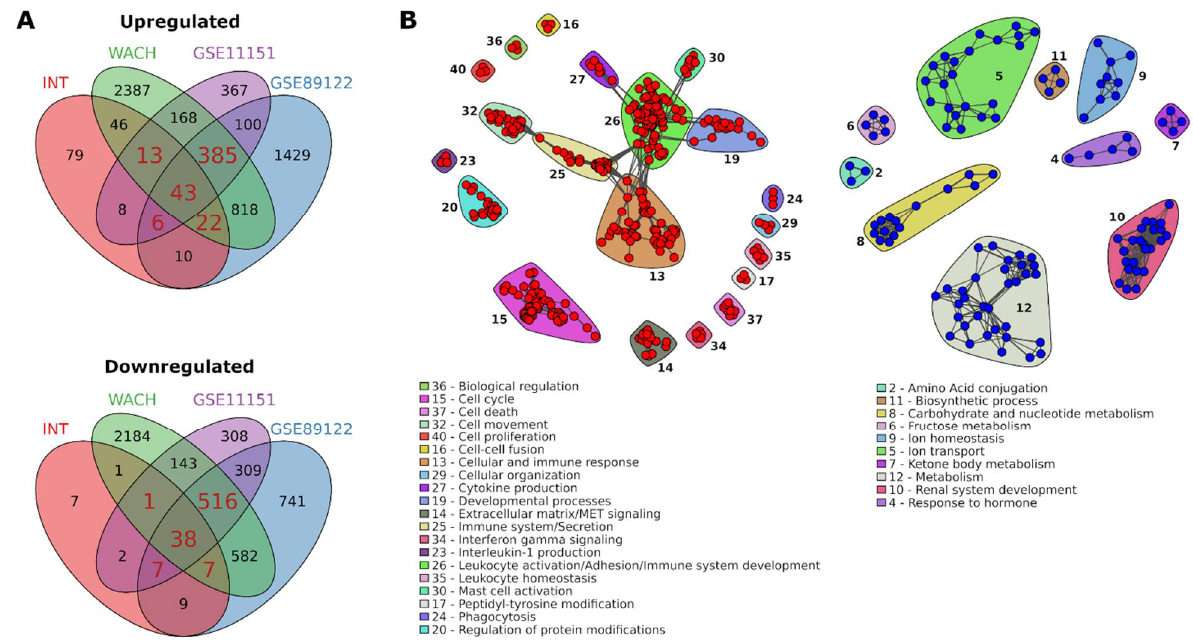
Figure 2. Validation and functional annotation of CDC deregulated genes. ( A ) Intersection of the genes significantly up- (upper panel) and downregulated (lower panel) in CDC versus normal kidney in INT cohort and three additional independent datasets. Genes found in at least three out of four datasets were highlighted in red; ( B ) network of pathways significantly over-represented (FDR < 0.05) in the list of validated differentially expressed genes. Red and blue nodes represent pathways significantly enriched in CDC and normal samples, respectively. Clusters of interconnected nodes identify pathways with genes in common above a Cohen’s kappa statistic of 0.35 and linked to the same biological process.